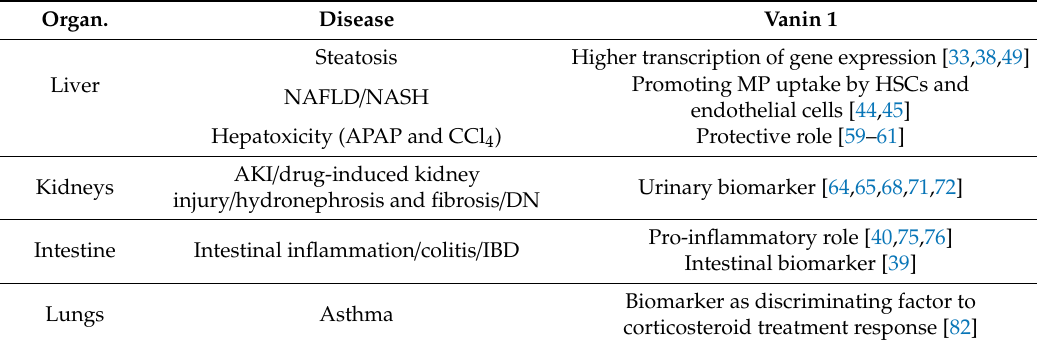
Table 1. Role of vanin 1 in diseases of organs in which it is highly expressed.